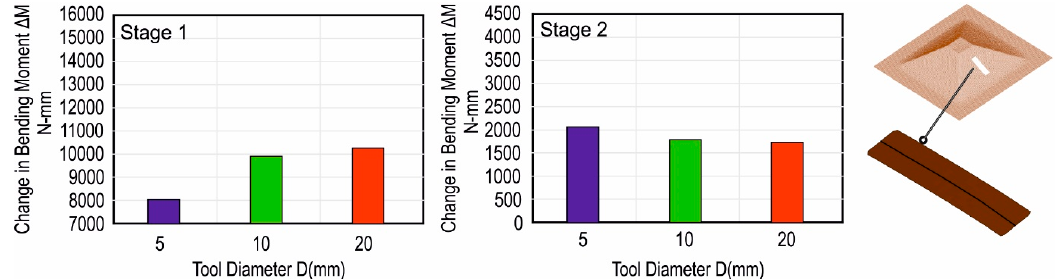
Figure 12. Change in the bending moment for different tool diameters upon unclamping (Stage 1) and upon trimming (Stage 2) along a section.